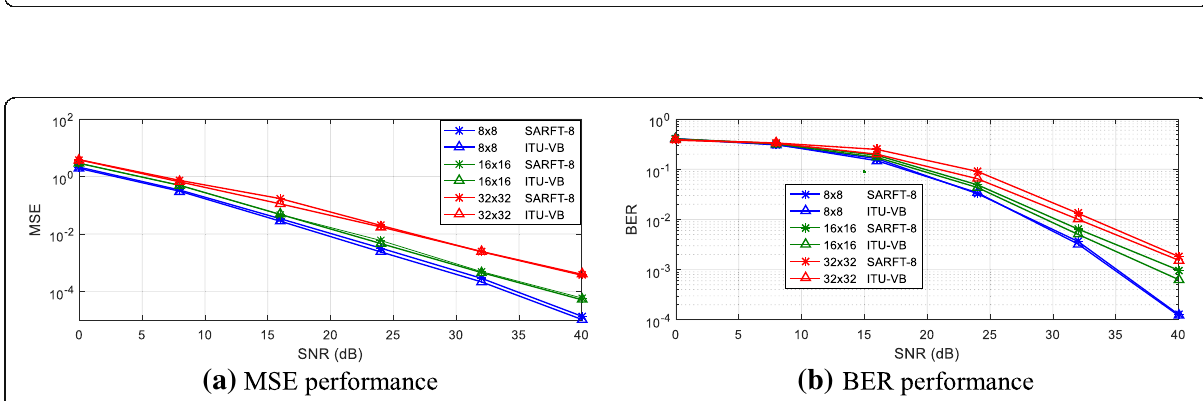
Fig. 7 The MSE and BER performance of the proposed PCS-information-based CS channel estimation scheme in 16 × 16 MIMO-OFDM system against f max